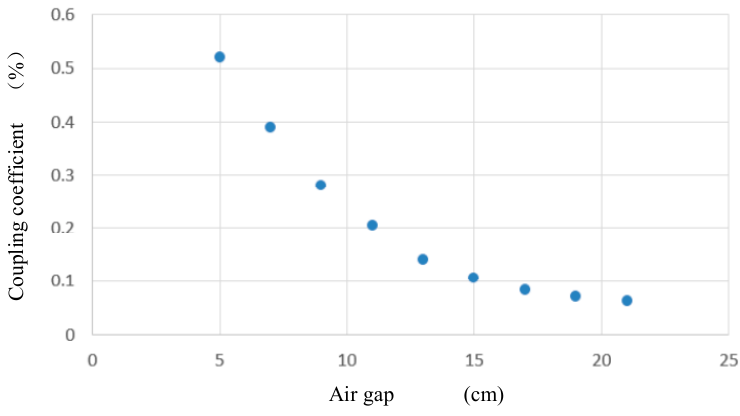
Figure 9. Coupling coefficient versus the air gap.